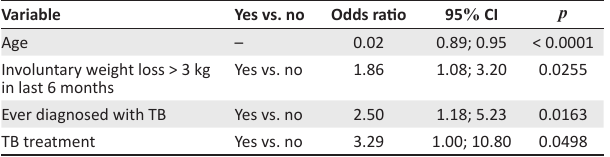
TABLE 5: Reported clinical manifestations associated with HIV status (rural). Variable